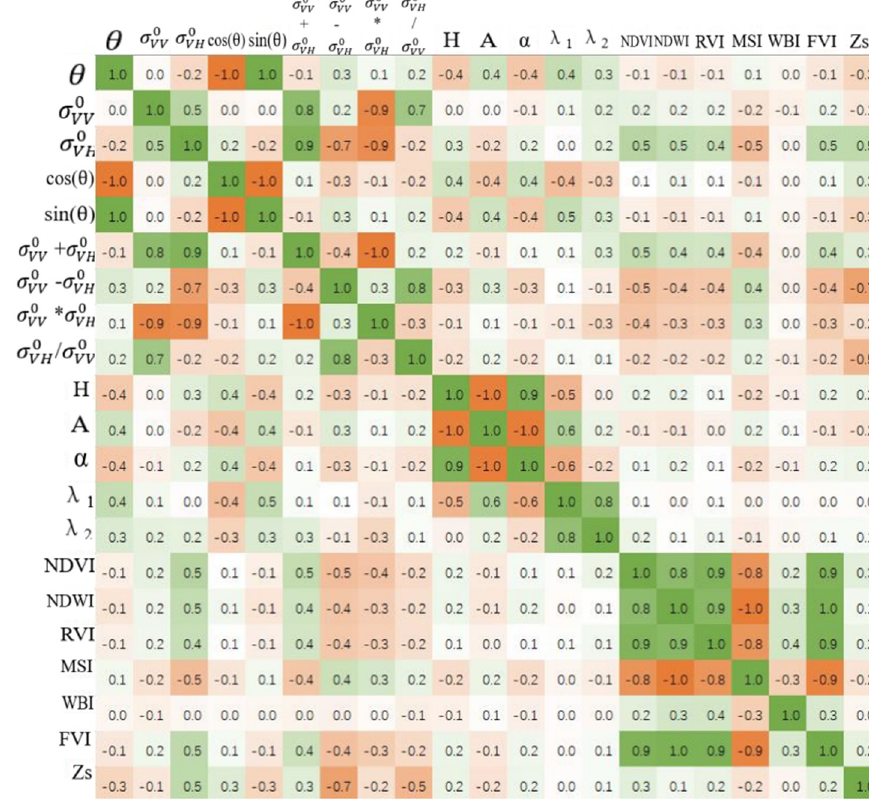
− 0.1462 Table 5. Ranking of feature importance using RF method. No.